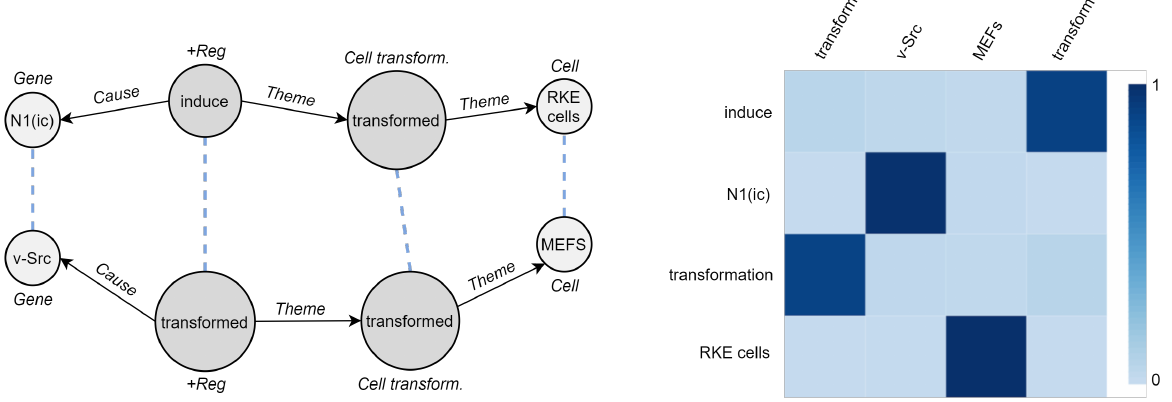
Figure 11. Qualitative example of DDEGK cross-graph attention, comparing two biomedical event graphs from CG13. Attention weights are visualized as a heatmap, while stronger node–node alignments are directly reported on the event graphs (dashed blue